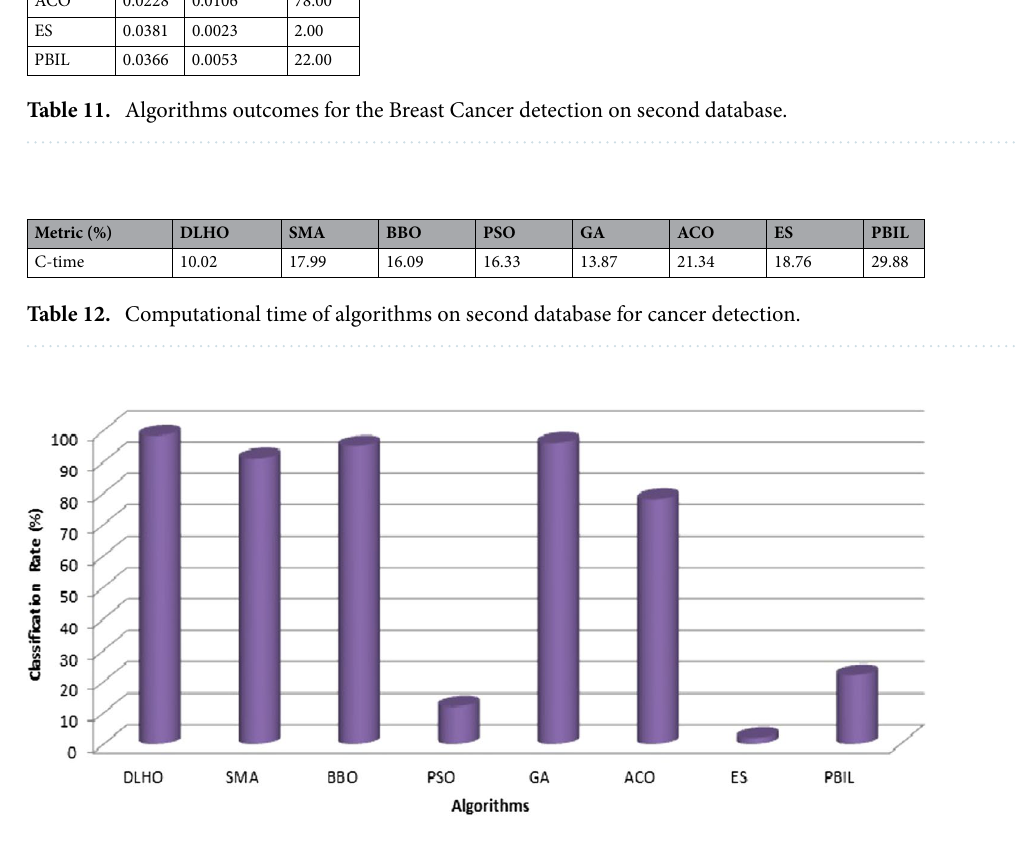
Figure 13. Breast Cancer detection Rate (%) of algorithms on second database.